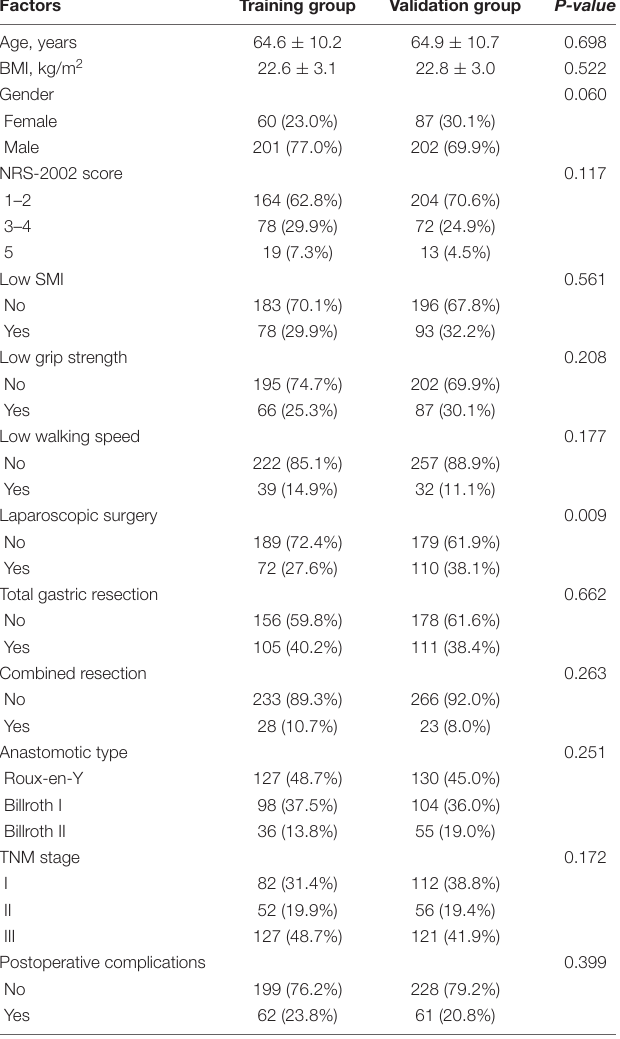
TABLE 1 | Clinical characteristics of patients.